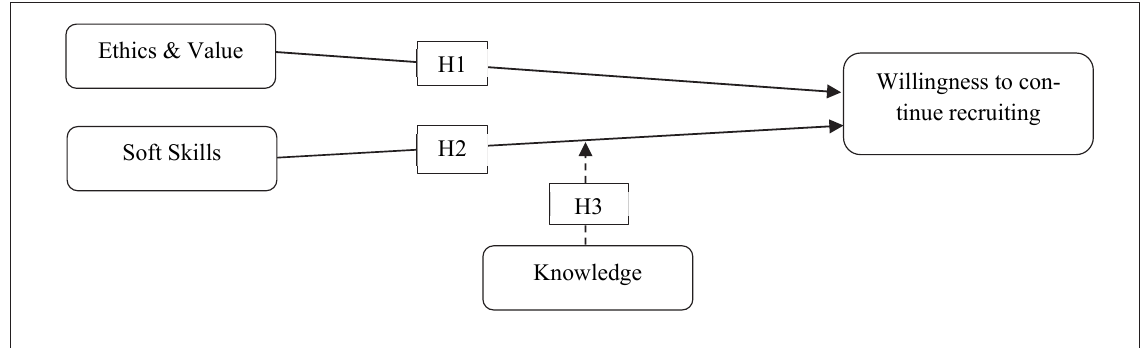
Fig. 1. Research Model Fig. 1. The research model of the